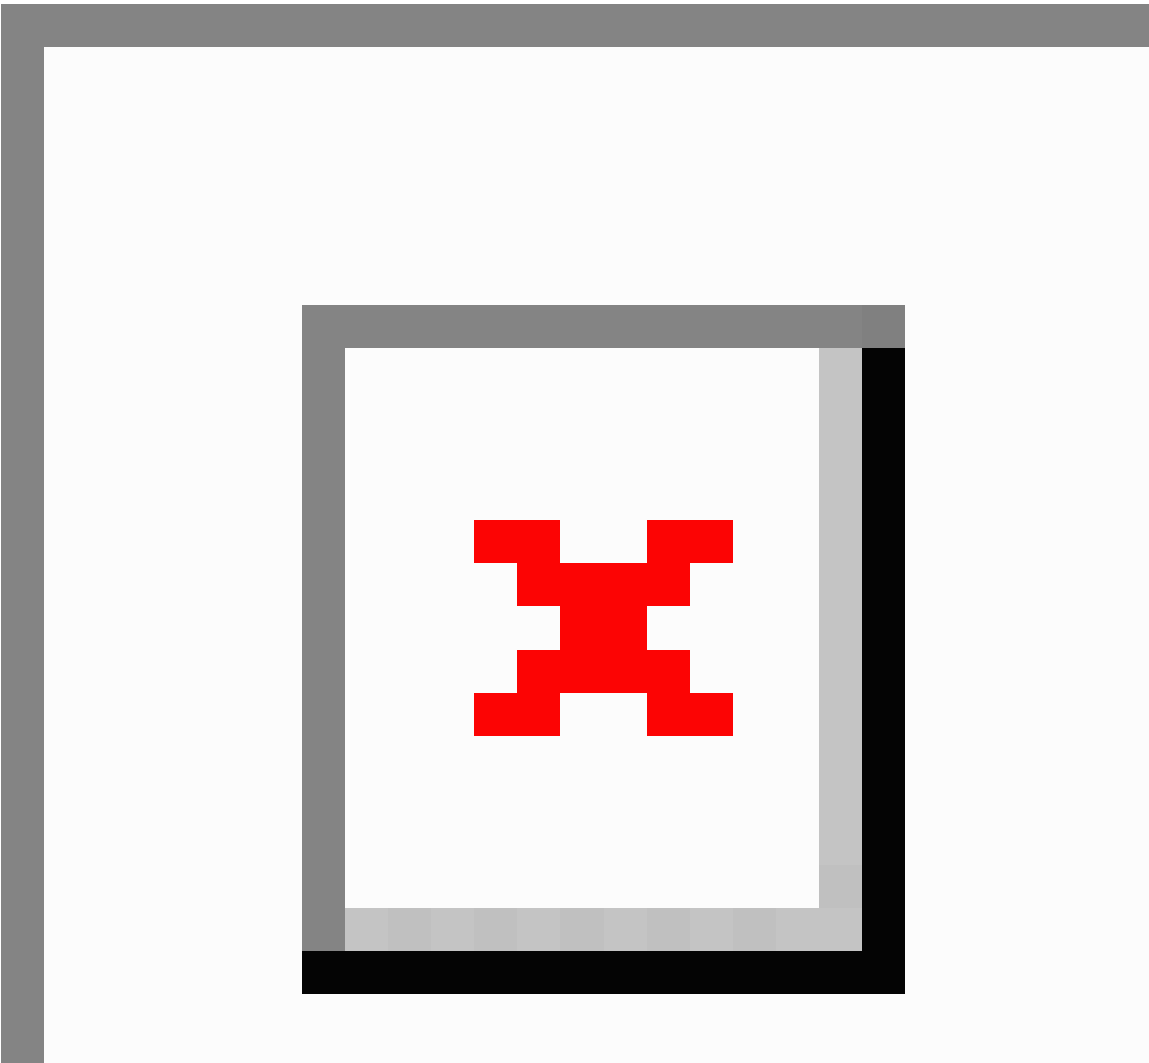
Figure 2. Scatter plot showing average daily PM2.5 values (y-axis) and the Weibo rate for 74 cities using our most correlated filter, AQ+”pollution”